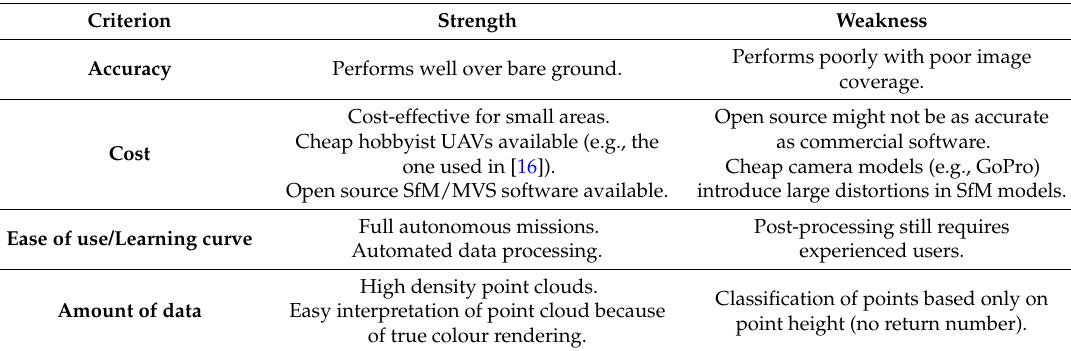
Table 3. A summary of strengths and weaknesses of SfM from UAV against defined criteria. Criterion Strength Weakness Accuracy Performs well over bare ground.